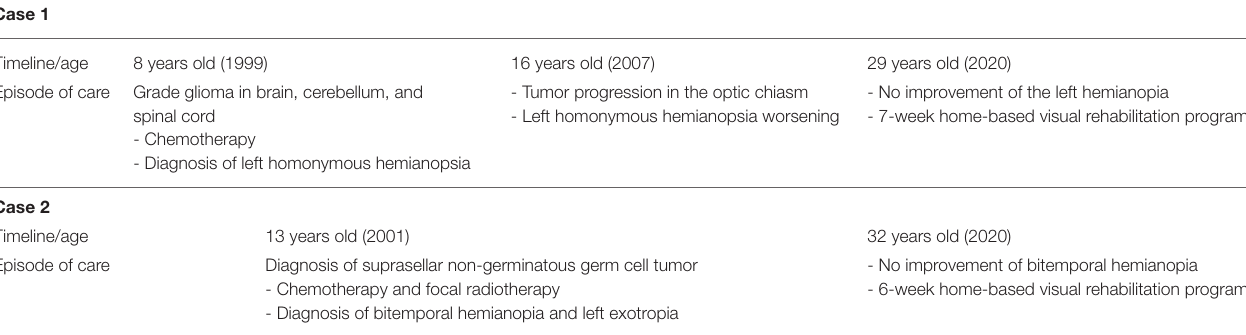
TABLE 1 | Summary of the episode of